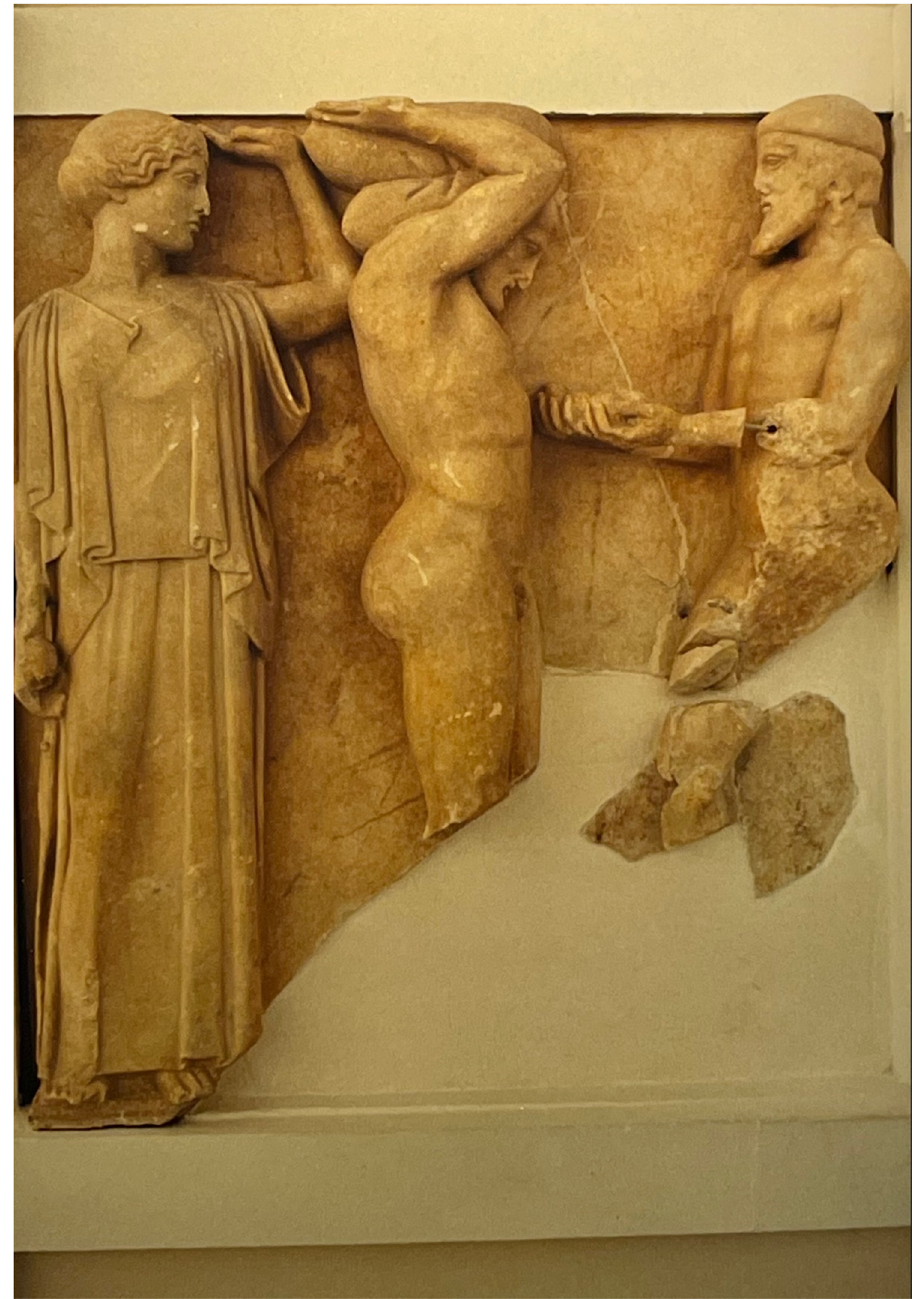
Figure 2: Athena, Atlas, and Heracles. Marble relief sculpture from the temple of Zeus at Olympia, ca. 460 BC . Source: Jørgen Bakke,